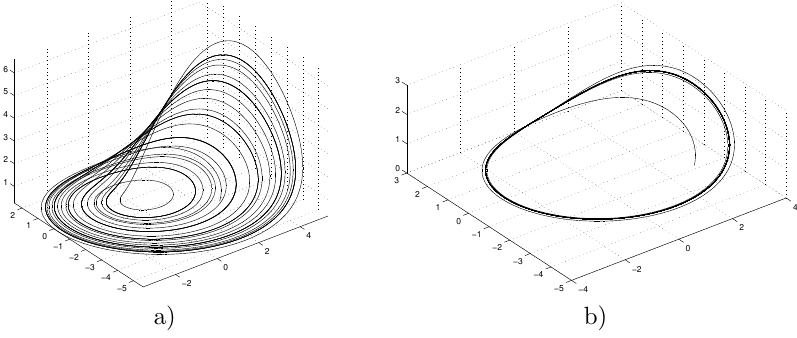
Figure 4. Results for the Roessler system: a) the three-dimensional phase diagram for a = 0 . 4, b) adapted Roessler system a = 0 . 25.